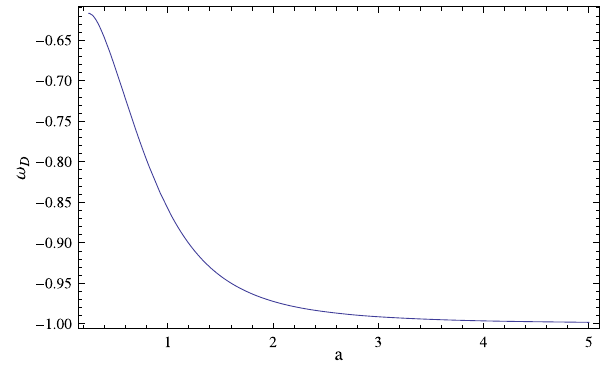
Fig. 4 Variation of EOS parameter with